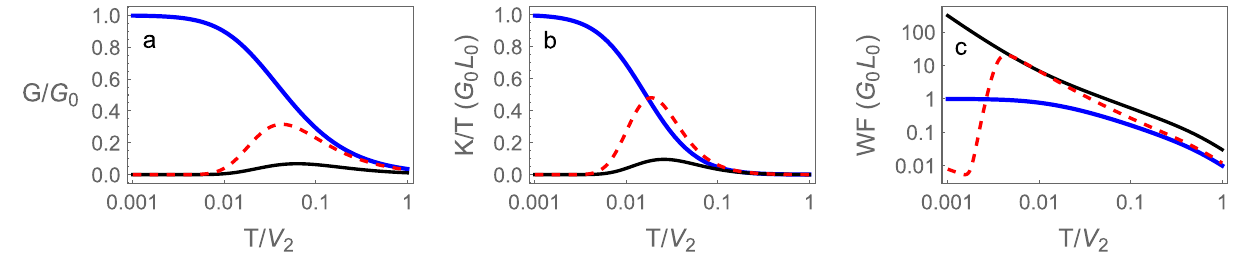
Figure 4. ( a ) Dimensionless electrical conductance, ( b ) thermal conductivity divided by temperature in units of G 0 L 0 and ( c ) Wiedemann–Franz ratio ( WF = ( K / T )/( G / G 0 ) ) in units of G 0 L 0 as functions of temperature for the device with SSH chains. In the trivial phase ( ˜ V = 1.03 ) black continuous, topological phase ( ˜ V = 0.97 ) red dashed and at the topological transition ( ˜ V = 1 ) blue